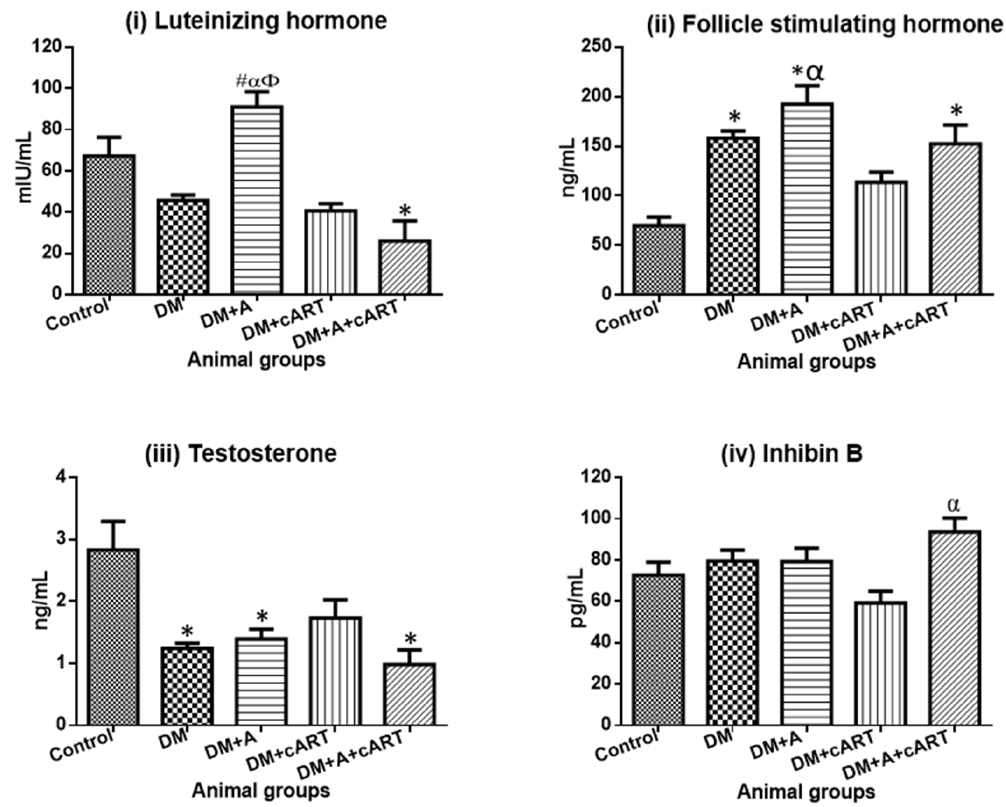
Figure 5. Graphs showing the mean ± SEM serum levels of reproductive hormones. *, #, α , and φ represent significant differences ( p < 0.05) as analyzed by the Bonferroni’s multiple comparison test: ‘*’ significantly different compared to the control group, ‘#’ significantly different compared to DM, ‘ π ’ significantly different compared to DM+A, ‘ α ’ significantly different compared to DM+cART, and ‘ φ ’ significantly different compared to DM+A+cART. Key: DM, diabetes; DM+A, diabetes and alcohol; DM+cART, diabetes and combination antiretroviral therapy; DM+A+cART, diabetes and alcohol and combination antiretroviral therapy.